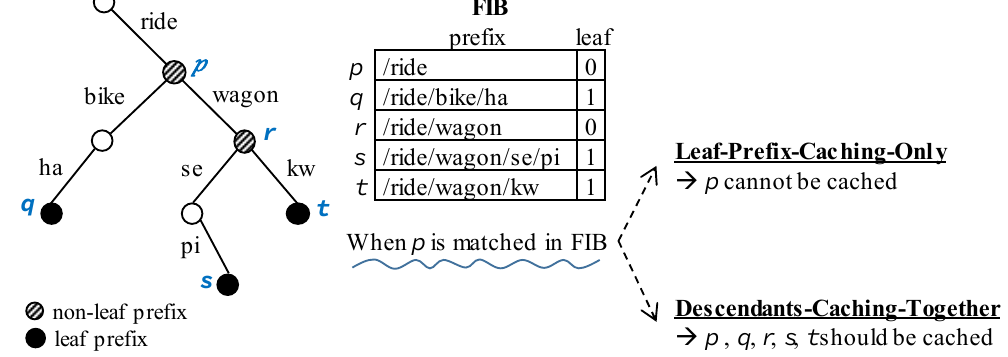
Figure 3. An example of FIB and two naïve caching approaches.